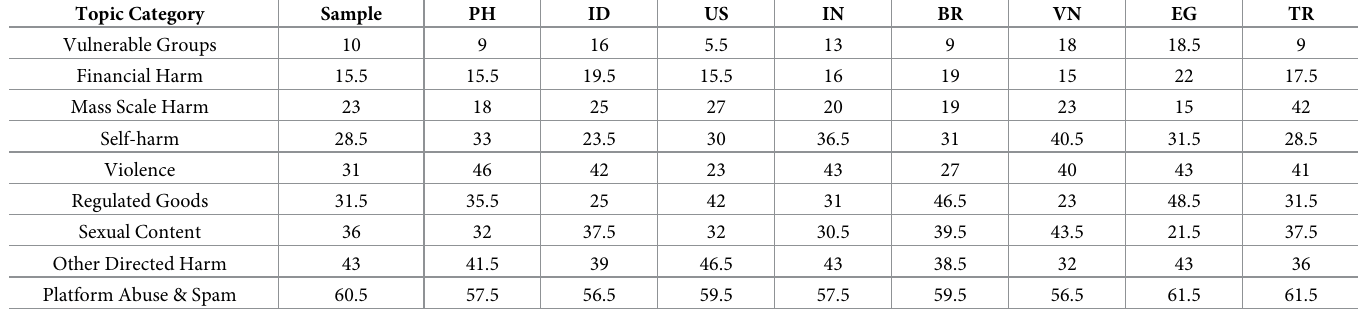
Table 6. Countries’ median ranking of each type of harmful content. 1 = most severe; 66 = least severe. The World ranking is a country-agnostic ranking instead of an aggregation from individual country